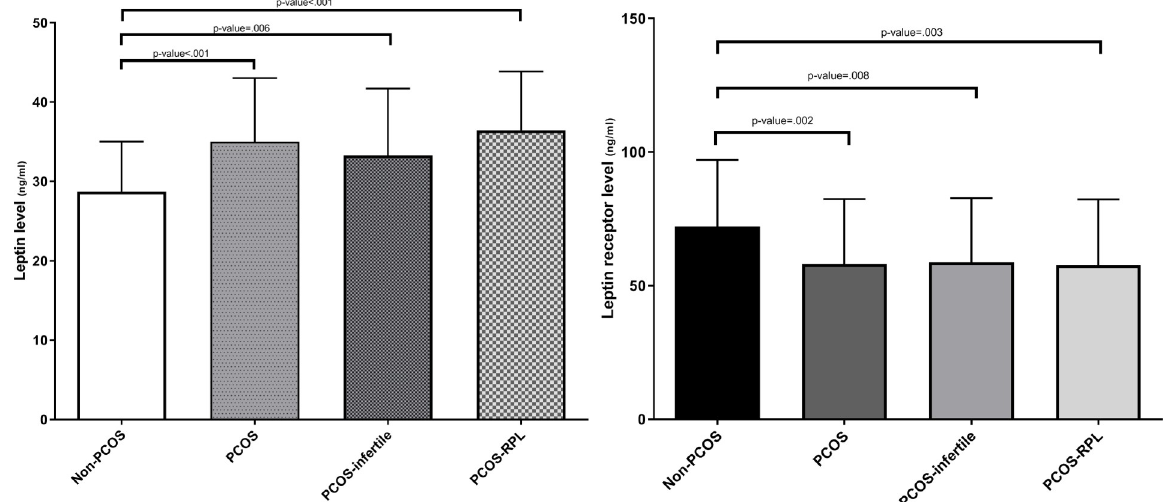
Fig 1. Leptin and leptin receptor levels of non-PCOS subjects and PCOS patients (PCOS-infertile and PCOS-RPL sub-groups).